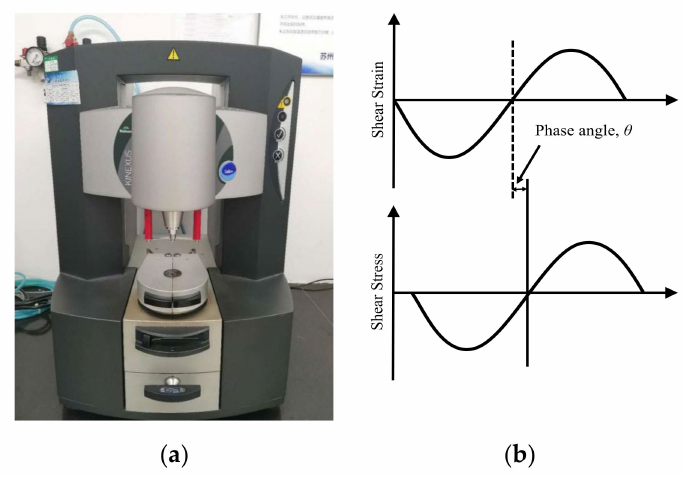
Figure 1. ( a ) Kinexus DSR device and ( b ) oscillation mode and operating